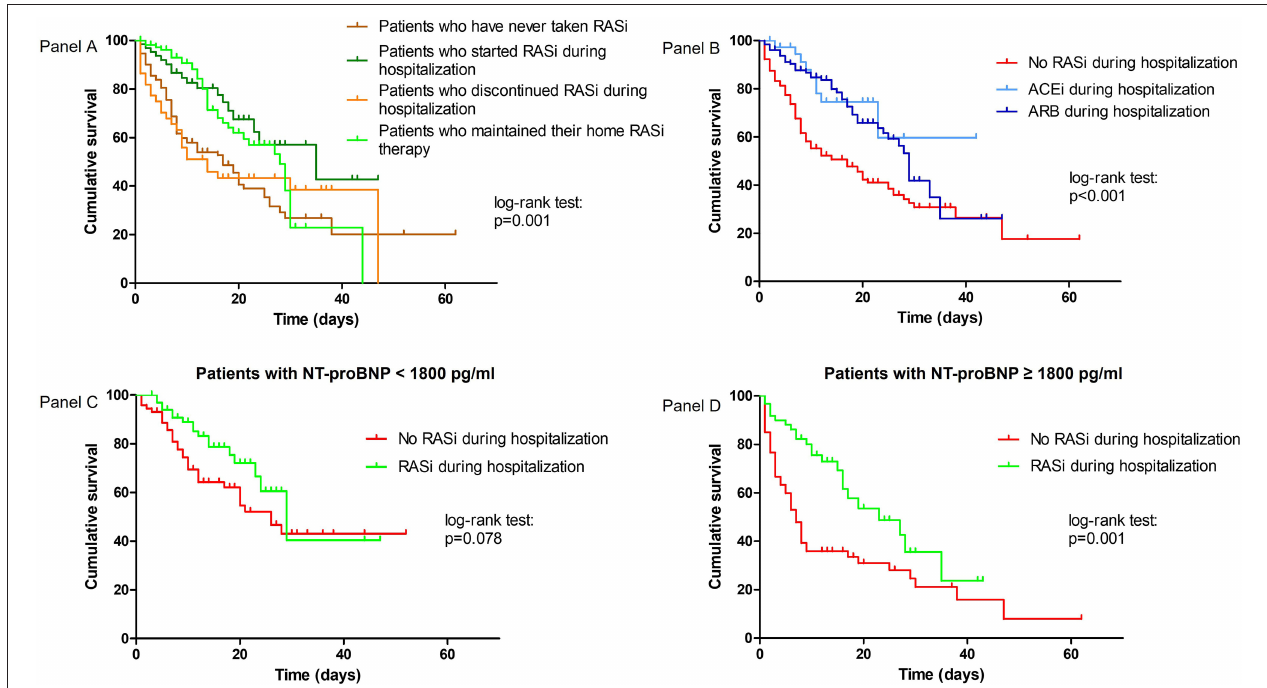
FIGURE 2 | Kaplan–Meier survival curves according to change in RASi therapy during hospitalization (A) , according to ACEi or ARB therapy during hospitalization (B) , and according to RASi therapy during hospitalization and admission NT-proBNP levels (C,D)